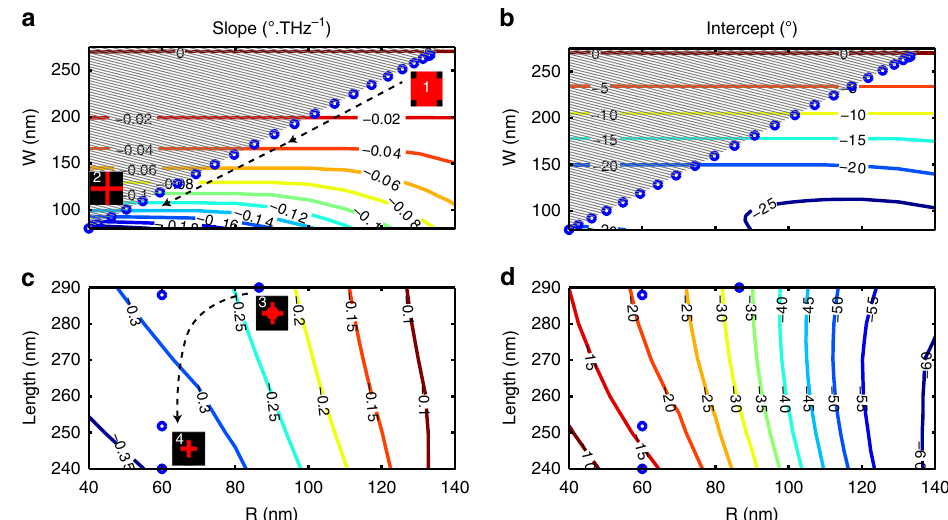
Fig. 2 Design strategy of the FAM. To control the slope a , c and the phase-shift intercept b , d , at least two parameters need to be controlled. The considered two parameters are the width and the radius ( W , R ) (from step 1 to step 2 in a , b ) and the length and the radius ( L , R ) (from step 3 to step 4 in c , d ). From step 1 to step 2, W varies from 80 to 270 nm, and, R varies from 60 to 135 nm while L is fi xed to 370 nm. From step 3 to step 4, L varies from 240 to 290 nm while W is fi xed to 80 nm to account for limitations in fabrication. Insets in a illustrate the evolution of the structure (top view) as one moves from the center (step 1) to the edge of the FAM (step 4), and, red/back colors represent TiO 2 /SiO 2